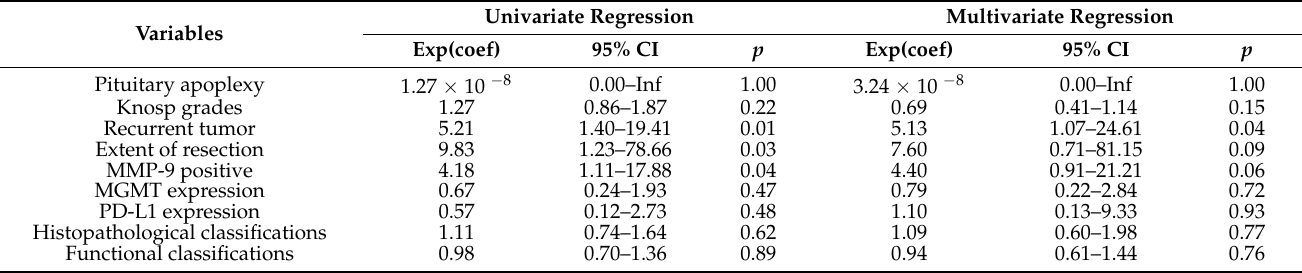
Table 3. Univariate and Multivariate Cox Regression Analysis for Tumor